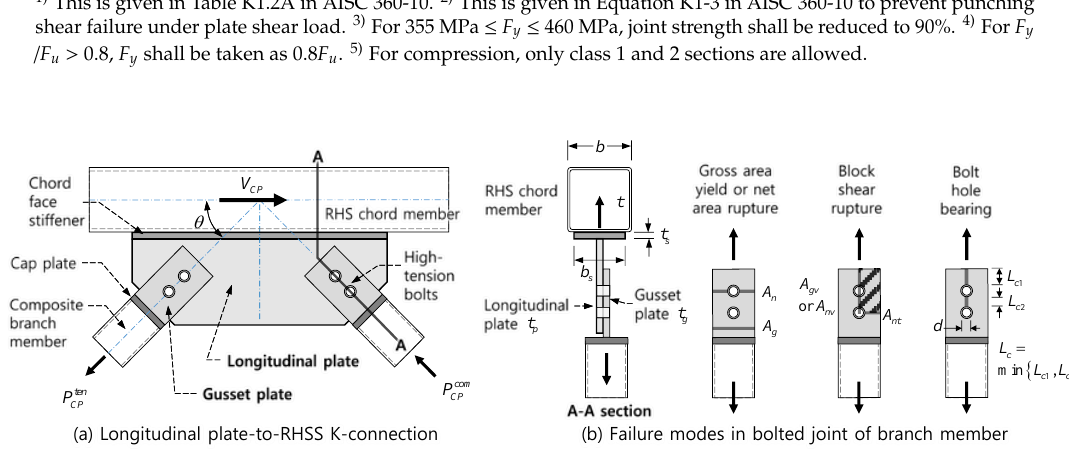
Figure 3. Longitudinal plate-to-RHS K-connection with bolted joint of chord members: ( a ) Longitudinal plate-to-RHS K-connection; ( b ) Failure modes in bolted joint of branch member.